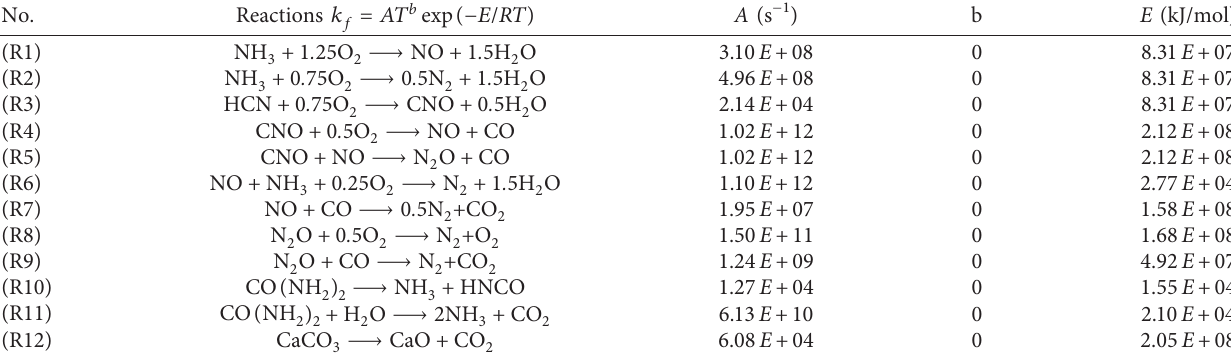
Table 1: The equations of the conversion of NO